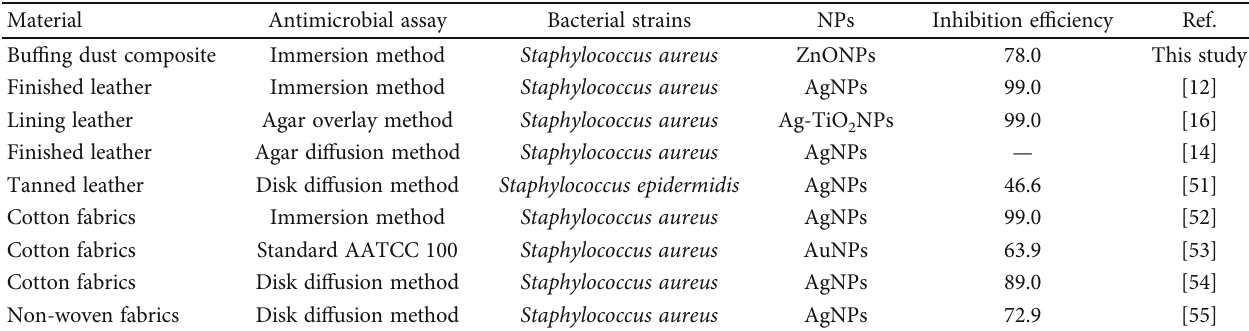
Table 3: Comparison of antibacterial performance of various studies.